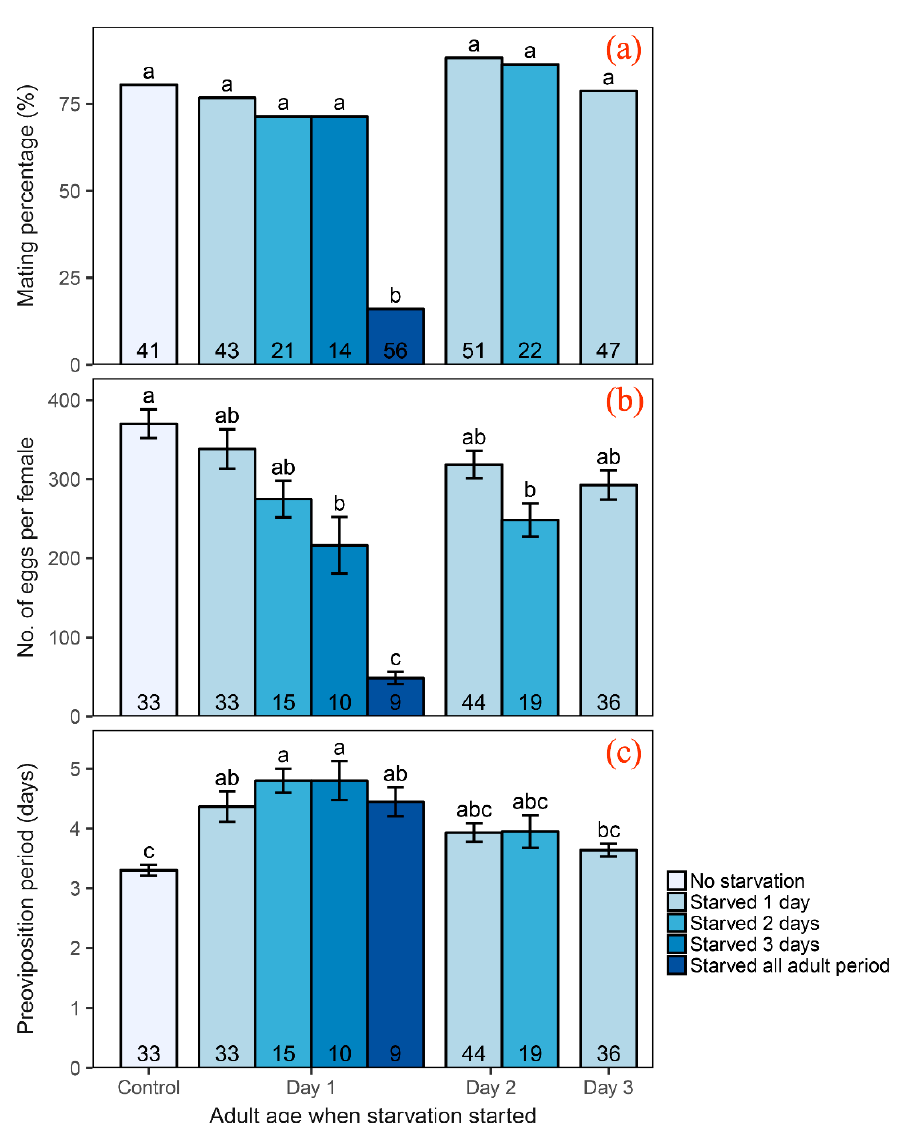
Figure 1. Mating percentage ( a ), fecundity ( b ) and preoviposition periods ( c ) of Cnaphalocrocis medinalis female after starvation. Different letters above the bars indicate significant differences between starvation durations ( p < 0.05), based on the result of chi-square test for mating percentage and Tukey’s HSD tests for fecundity and preoviposition periods. The numbers in the bars indicate sample sizes. Starvation reduced female fecundity of C. medinalis , but the e ff ect of starvation on the